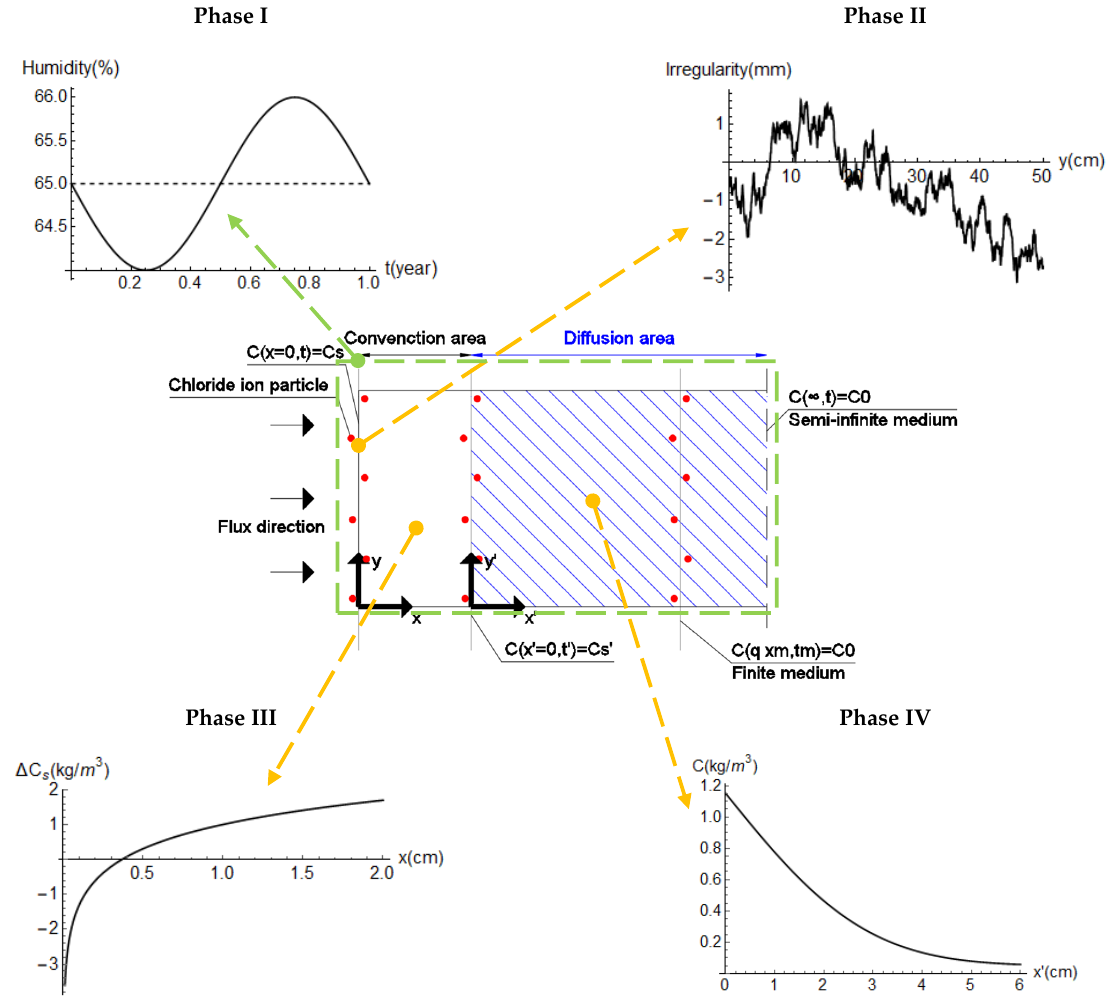
Figure 3. Proposed model ( middle ) and phases: ( above ) environmental conditions and concrete irregularity; ( below ) increment of C s and diffusion process. The model is composed of two reference systems: x, y, t, and x’, y’, t.